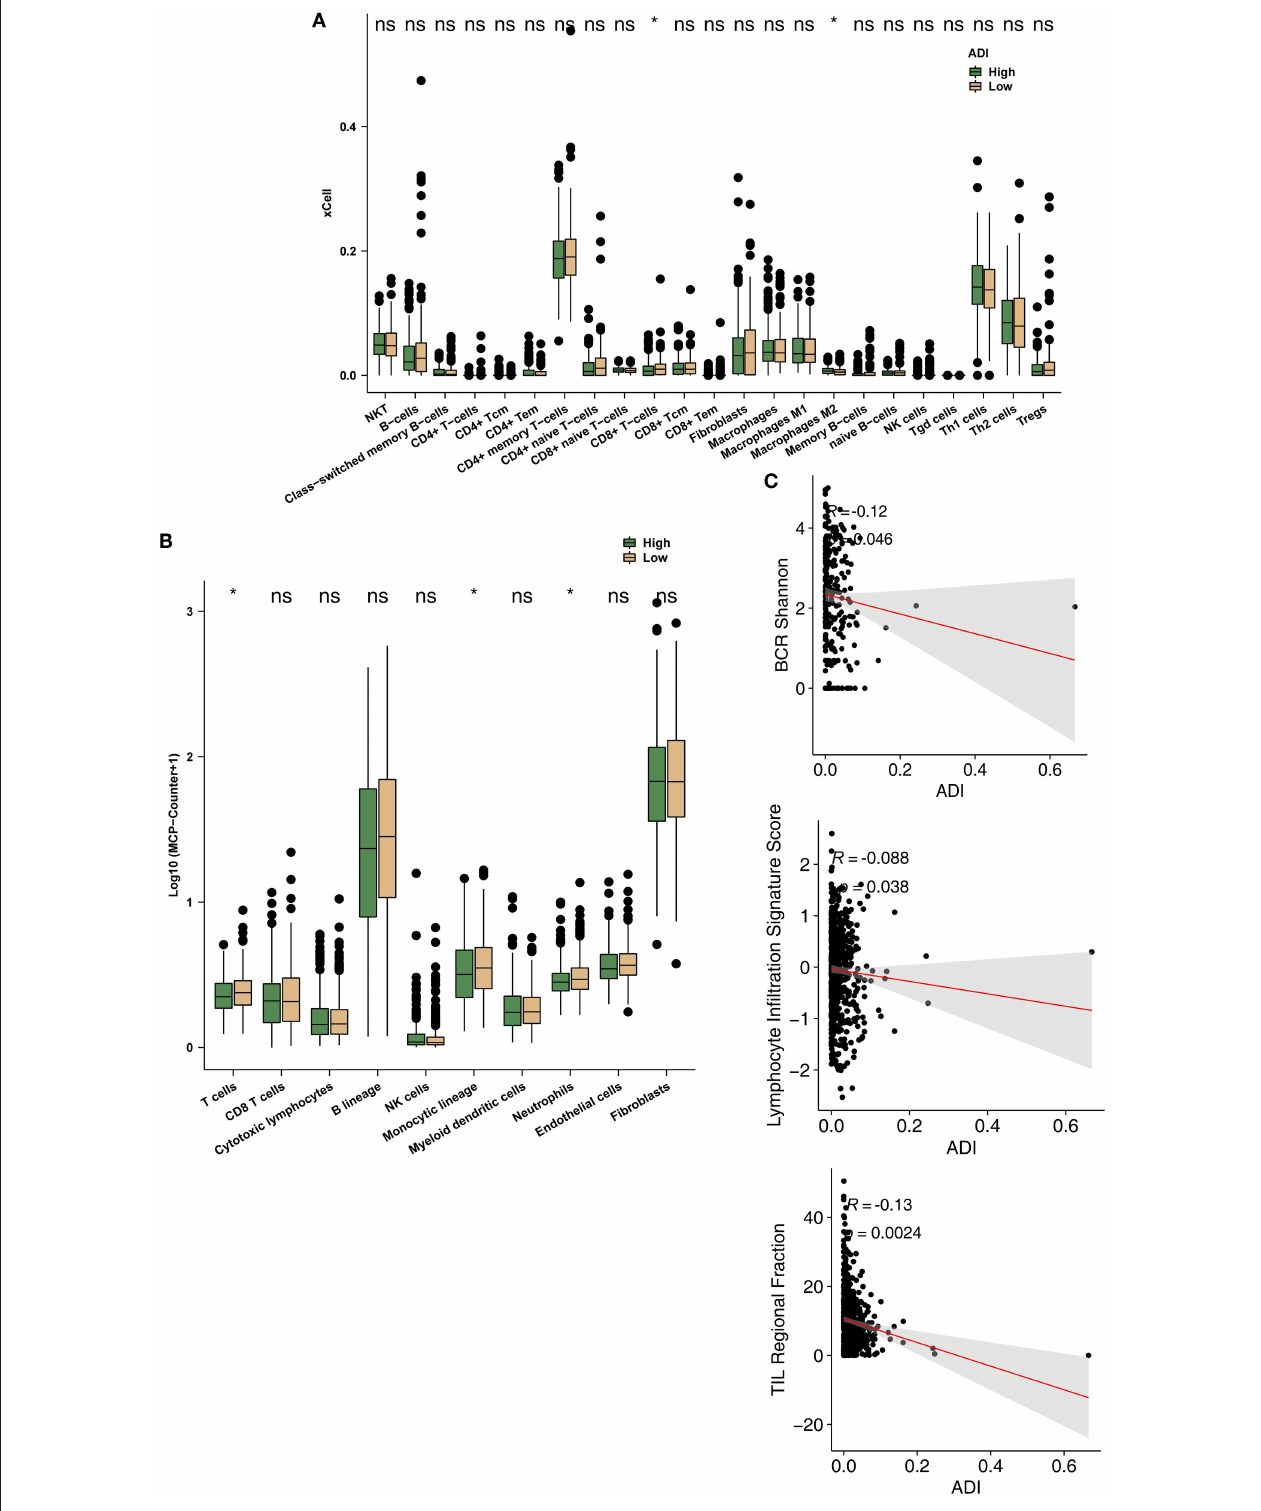
FIGURE 5 | Comparison of immune infiltration between the high-ADI and low-ADI groups. (A) Comparison of immune cell infiltration estimated by xCell between the high-ADI and low-ADI groups. (B) Comparison of immune cell infiltration estimated by MCP-Counter between the high-ADI and low-ADI groups. (C) Comparison of immune-related signature scores between the high-ADI and low-ADI groups. (* P < 0.05 Mann-Whitney U test). ns: not